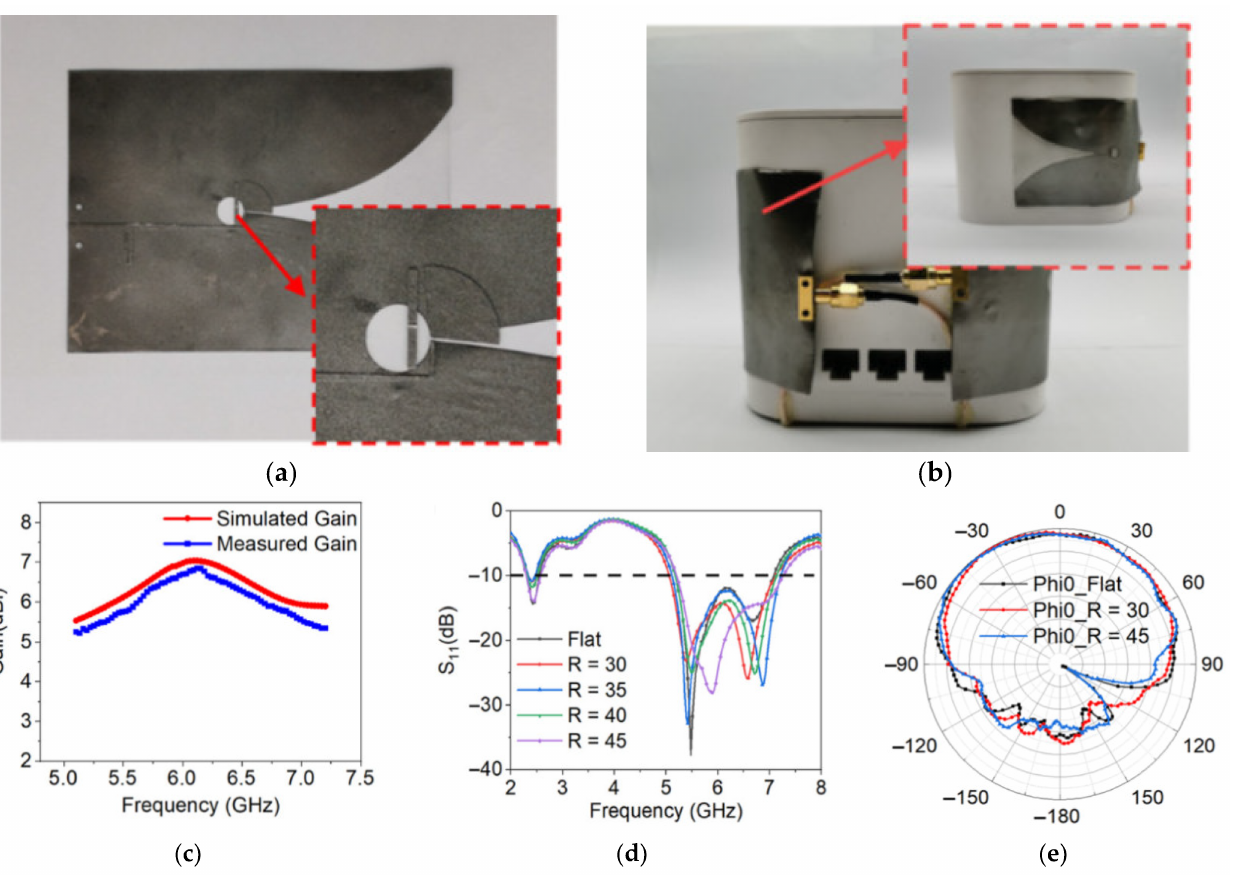
Figure 23. ( a , b ) Fabricated prototype and ( c – e ) some results of the conductive graphene-based conformal dual-band Vivaldi antenna